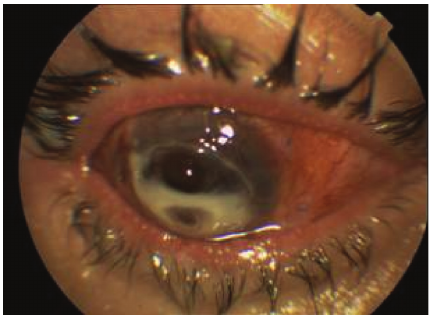
Figure 4: Clinical picture of the right eye after the first amniotic membrane transplantation. There is marked corneal thinning and